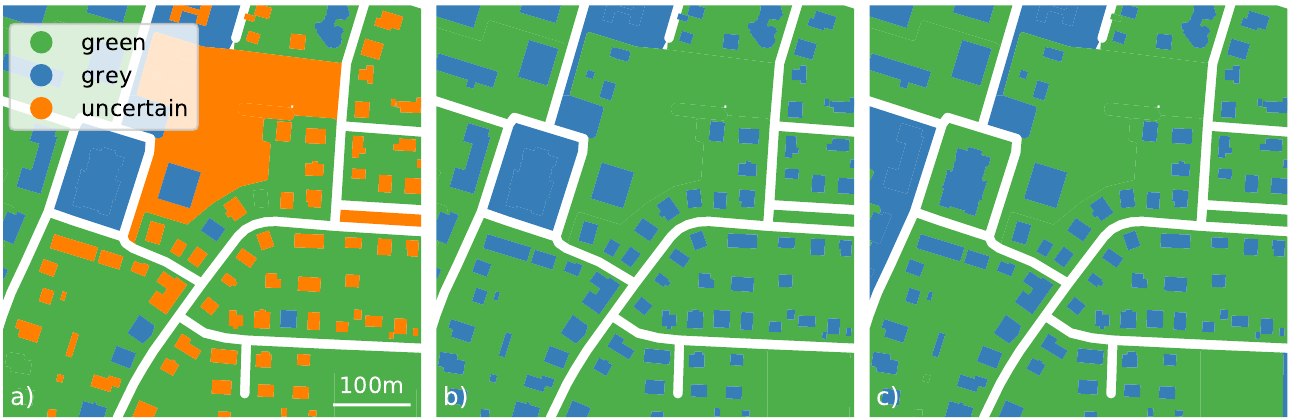
Figure 8. Greenness classifications for a subset of the study site derived from Sentinel-2 ( a ), OSM + Sentinel-2 ( b ), and aerial imagery as ground truth ( c ). The class with the highest pignistic probability is shown. If pignistic probability = 0.5, object was labeled as uncertain . The polygon on the far left was misclassified, since it contained a high amount of mixed pixels and no land use related OSM